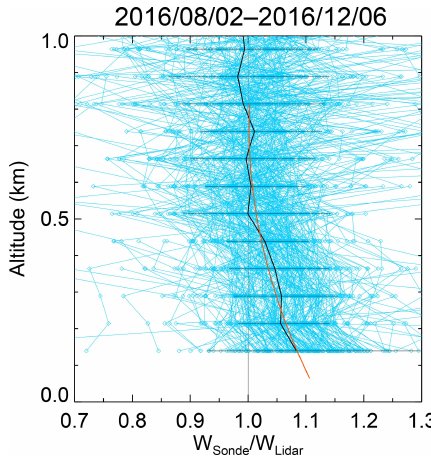
Figure 5. Vertical distribution of the ratio of w obtained by ra- diosonde ( w Sonde ) to w obtained with the MRL system without beam overlap correction ( w Lidar ) from 2 August to 6 Decem- ber 2016. The individual profiles are shown by the thin blue lines with diamonds. The solid black line and the error bars are averages and standard deviations over a 75m height interval. A quadric curve (orange line) was fitted to the averaged